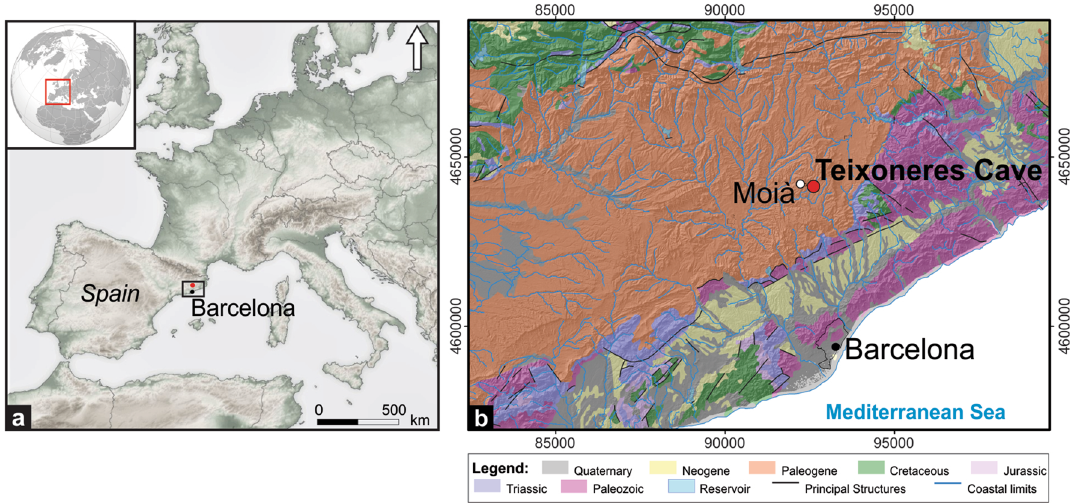
Figure 1. ( a ) Location of Teixoneres Cave. ( b ) Location of Teixoneres Cave and simplified regional geological map of the Moià area. The maps were obtained from an open access source of the Instituto Geológico y Minero de España (IGME), (June 10, 2020) [https ://info.igme.es/carto grafi adigi tal/geolo gica/Geolo gicos 1MMap a.aspx?Id=Geolo gico1 000_(1994)&langu age=es], and prepared with the Adobe Photoshop CS5 Version